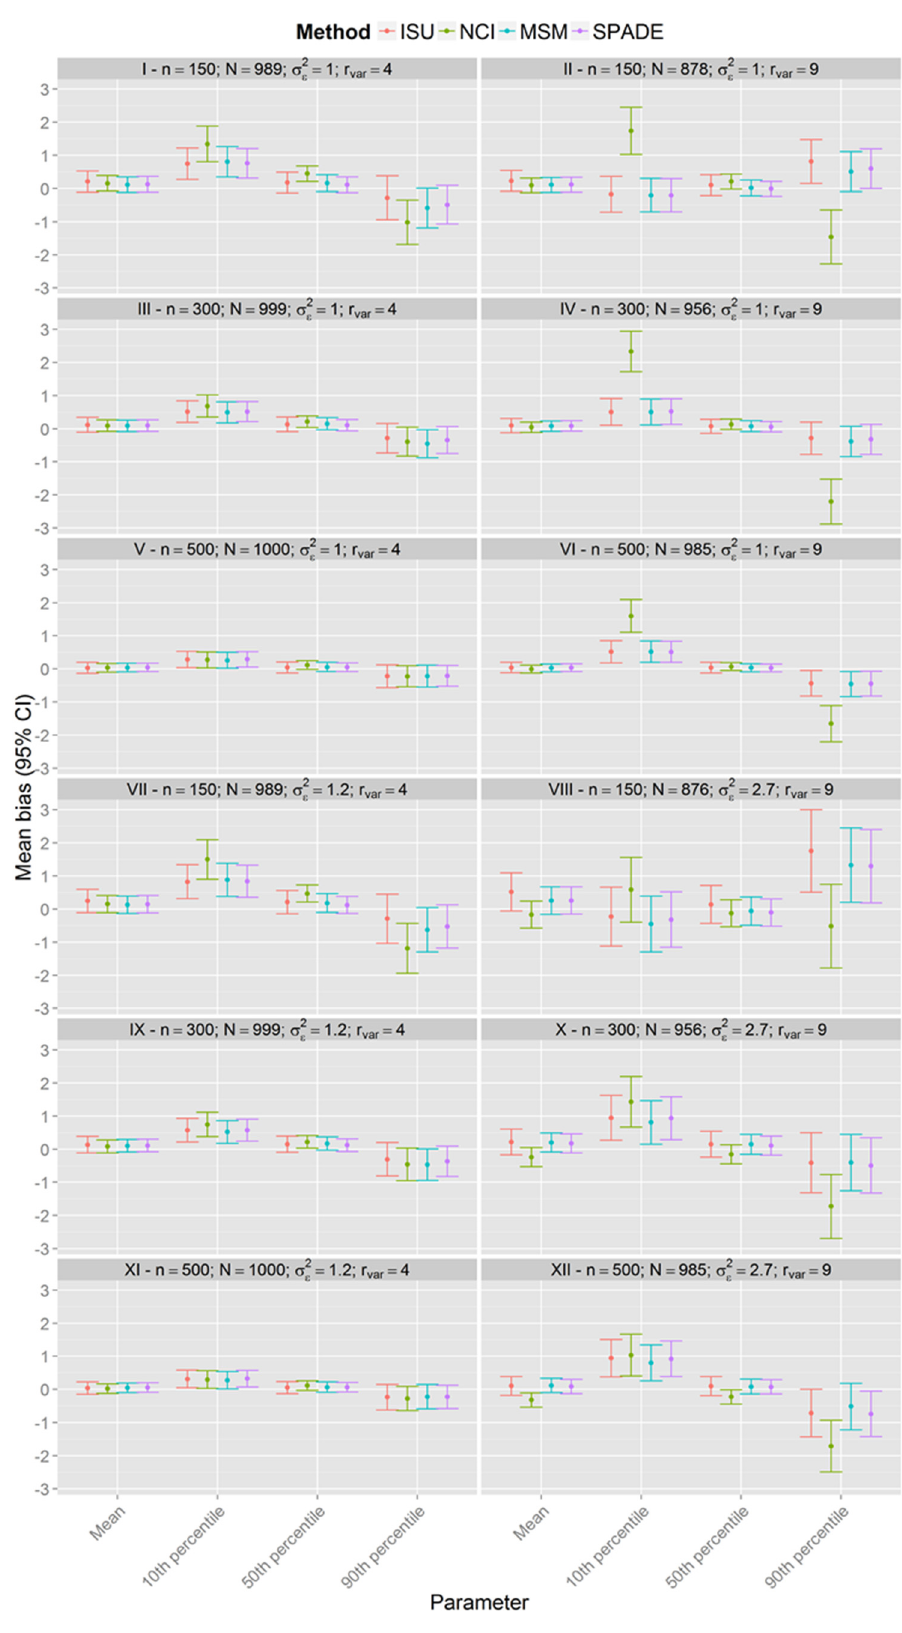
Figure 4. Bonferroni confidence interval for the mean bias with 95% confidence level for each scenario for samples with estimated between-person variance different from zero for all methods (n indicates the sample size and N the number of usable simulated samples).